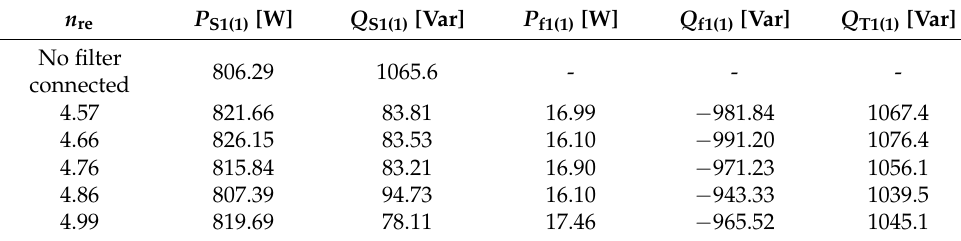
Table 9. Fundamental harmonic active and reactive power measured in the laboratory